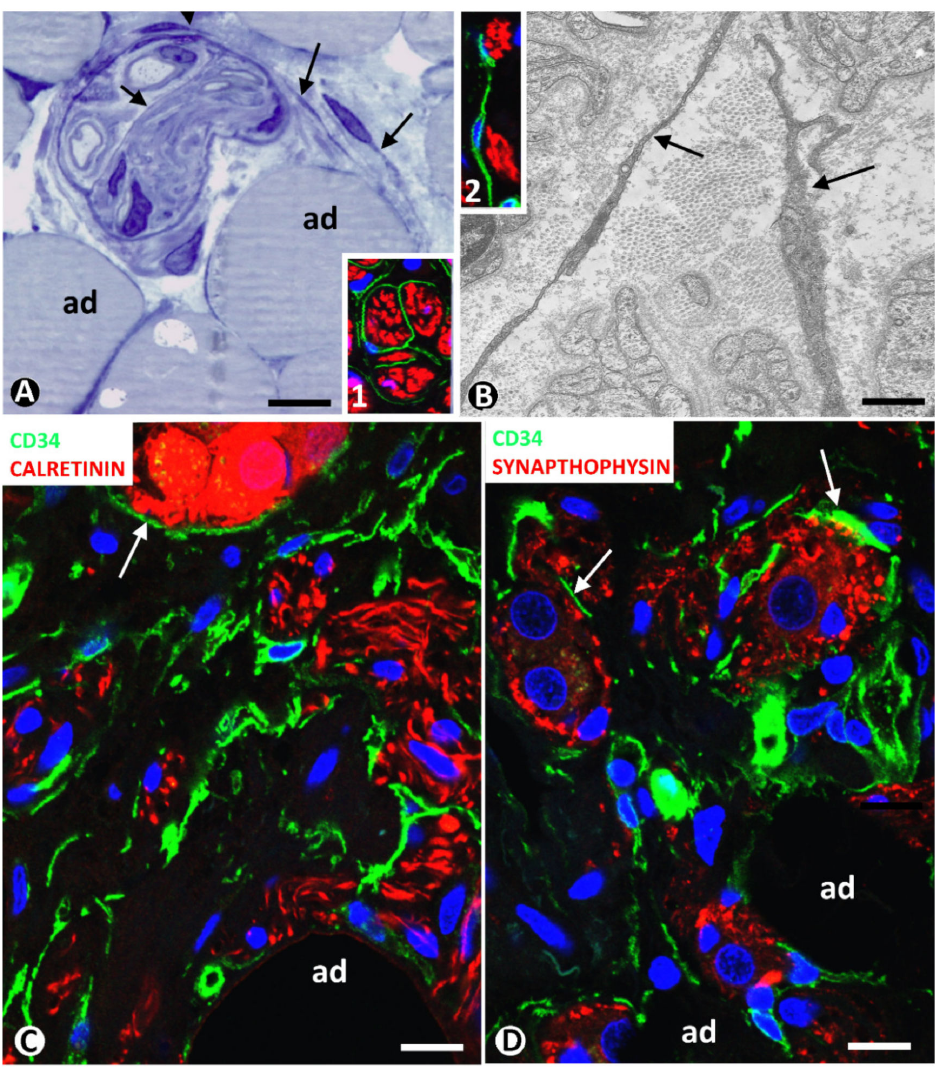
Figure 4. ( A , B ) TCs / CD34 + SCs in neuromas. ( A ): a nerve fascicle between adipocytes (ad), TCs (arrows) are observed around and within the fascicle in a semithin section stained with toluidine blue. ( B ): ultrastructural image showing TC telopodes (arrows) around nerve fibres. Ultrathin section. Uranyl acetate and lead citrate. Inserts in ( A , B ), TCs / CD34 + SCs (green) and Schwann cells (red) shown by double immunofluorescence labelling for CD34 (green) and S100 protein (red). ( C , D ): TCs / CD34 + SCs (green) around nerve fibres and neuro-glial units (arrows) (red) between adipocytes (ad) in a hyperplastic neurogenic process. Double immunofluorescence labelling for CD34 (green) and calretinin (( C ), red) or synaptophysin (( D ), red). Bar: ( A , C , D ): 40 µ m; ( B ): 4 µ m; inserts of ( A ) and ( B ): 50 µ